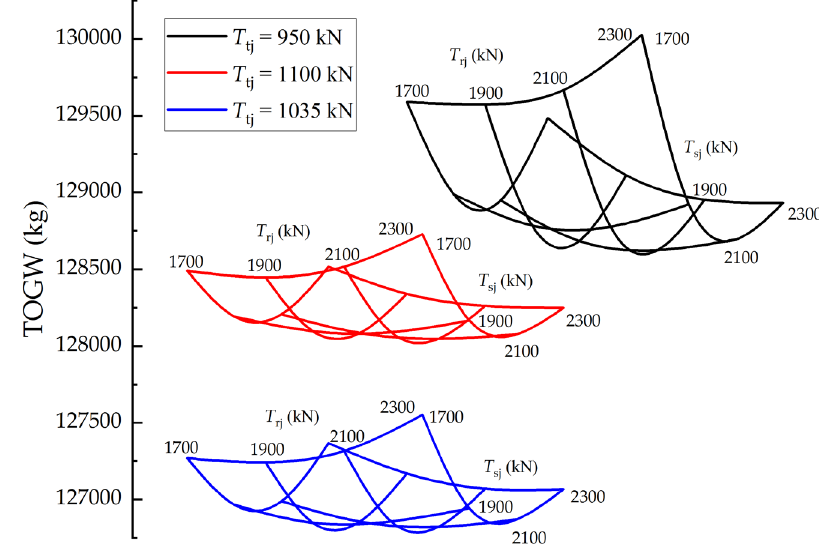
Figure 9. Carpet plot of the TOGW with the thrust of the three engine modes.